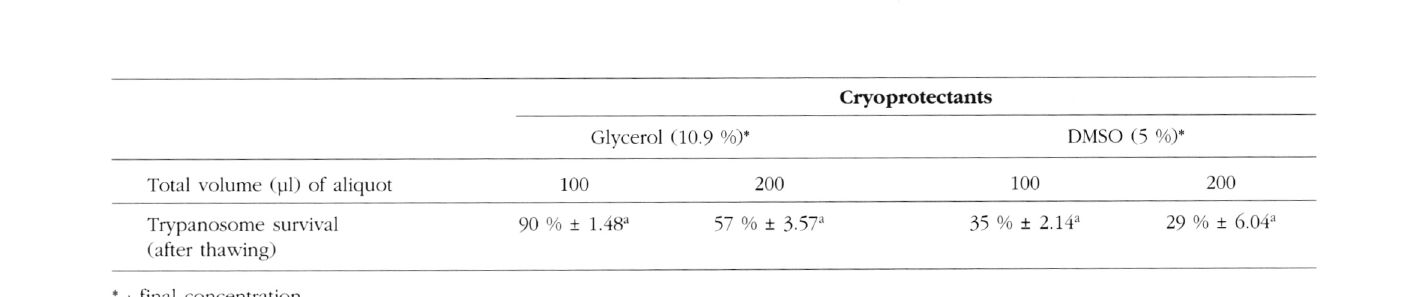
Table I. — Comparison between the results obtained with glycerol and DMSO for the cryopreservation of T. vivax , using ten cryostabi- lates of 100 μl and 200 μl aliquots (total volume). Data are presented as mean ± SD. These data are representative of three individual experiments performed. Means having the common superscript “a” are significantly different from each other (p <